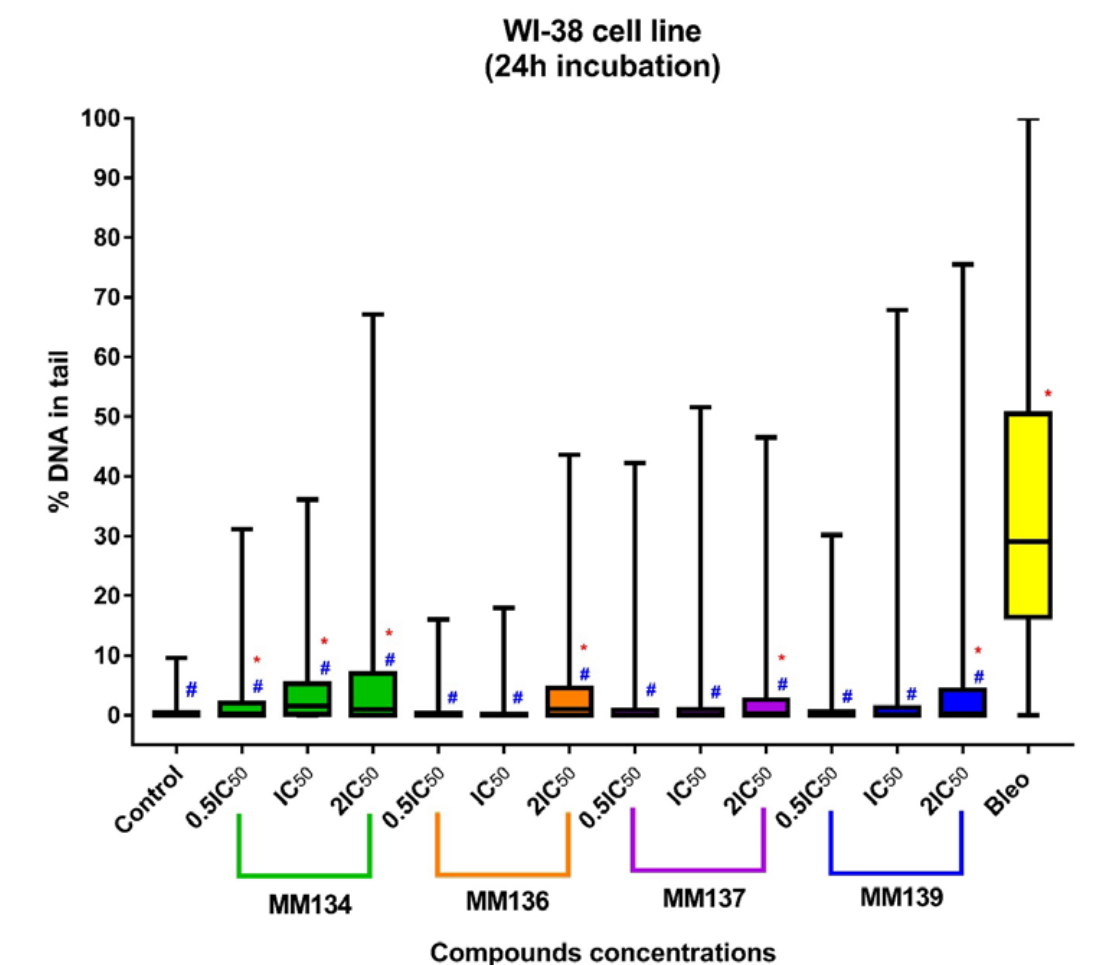
Figure 6. DNA damage in normal cells estimated with 24 h alkaline comet assay: determination of DNA damage induced by 0.5 × IC 50 , IC 50 , and 2 × IC 50 concentrations of MM134 , -6 , -7 , and -9 in the WI-38 cell line. Data are represented as median tail DNA % with interquartile range and minimal and maximal values. The Kruskal–Wallis test was used to show a statistically significant difference between groups. Multiple comparisons using mean ranks for all groups module of Statistica software were used. In all groups, N > 200. * significant difference compared to the negative control; p < 0.05. # significant difference compared to the positive control (20 µ M bleomycin); p < 0.05. Tested compounds used in concentrations followed by IC 50 values (0.5 × CI 50 , IC 50 , and 2 × IC 50 ) induced a dose-dependent and statistically significant increase in DNA damage compared with the negative and positive control ( p < 0.05) in both BxPC-3 and PC-3 cell line (except MM137 used in 0.5 × IC 50 compared to negative control in PC-3 cell line) following 24 h incubation time. DNA damage expressed as a median of “tail DNA %” parameter obtained in CASP software for cells incubated with IC 50 concentrations of tested pyrazolo[4,3- e ]tetrazolo[1,5- b ][1,2,4]triazine derivatives descendent in the order of: MM136 (IC 50 = 0.25 µ M; median = 8.28%; mean = 14.36%), MM139 (IC 50 = 0.33 µ M; median = 4.74%; mean = 10.85%), MM137 (IC 50 = 0.16 µ M; median = 3.28%; mean = 12.07%) and MM134 (IC 50 = 0.32 µ M; median = 2.5%; mean = 10.9%) for BxPC-3 cell line and MM139 (IC 50 = 0.17 µ M; median = 3.35%; mean = 14.22%), MM137 (IC 50 = 0.11 µ M; median = 2.32%; mean = 11.05%), MM136 (IC 50 = 0.13 µ M; median = 1.63%; mean = 12.08%) and MM134 (IC 50 = 0.16 µ M; median = 1.03%; mean = 7.37%) for PC-3 cell line (Figure